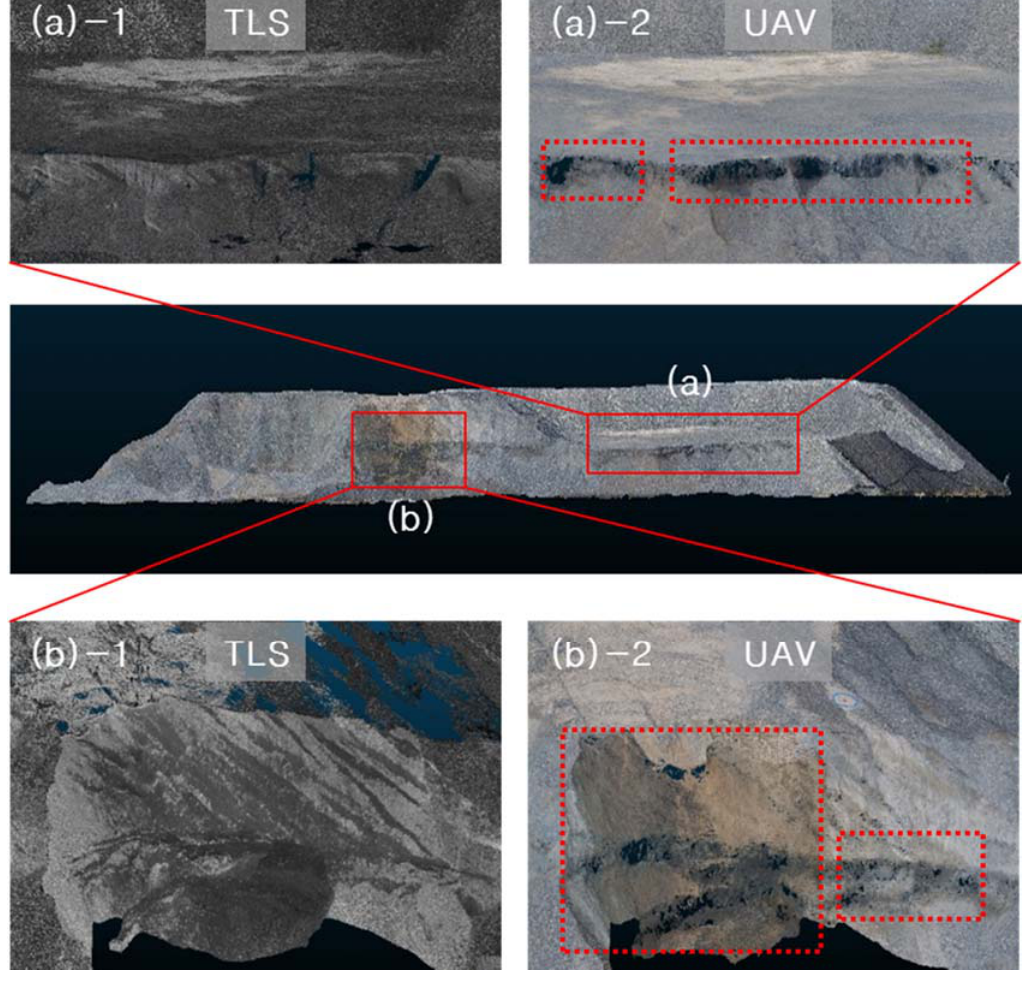
Figure 5. Side views of the point clouds taken at the waste disposal site: ( a ) ‐ 1 TLS ‐ based point cloud and ( a ) ‐ 2 UAV ‐ based point cloud; ( b ) ‐ 1 TLS ‐ based point cloud and ( b ) ‐ 2 UAV ‐ based point